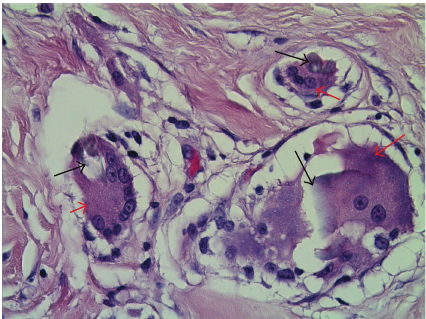
Figure 2: Pathology showing multinucleated giant cells (red arrow) surrounding the silicone particles (black